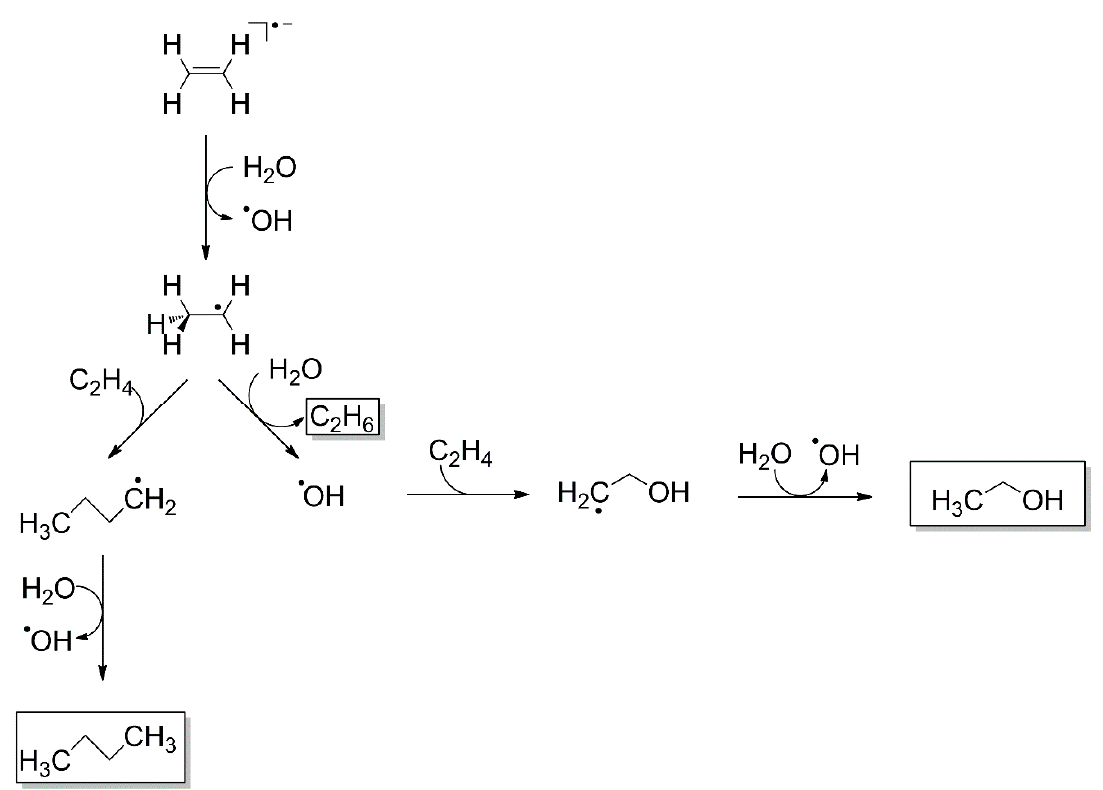
Figure 9. Energy dependence of the integrated desorption signal of H 2 CO obtained by TDS after electron irradiation of CO/H 2 O (1:1) mixed ices with 250 µ C/cm 2 . The resonance at 4 eV was assigned to EA to CO yielding CO •− . The solid line serves as a guide to the eye. Adapted with permission from Ref. [24]. Copyright 2019 American Chemical Society.